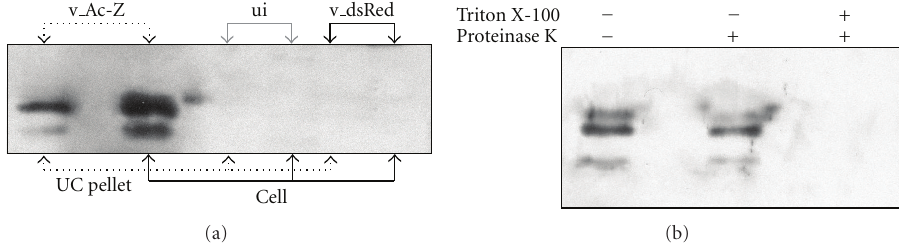
Figure 5: Western Blotting with α -Tio-Z-V5-His. (a) The ultracentrifugated supernatant (UC pellet) and cellular extract (Cell) of Sf9 cell fractions infected with recombinant v Ac-Z were loaded in lanes 1 and 2. The same fractions were loaded for uninfected cells (ui, lanes 3 and 4) and control v dsRed (recombinant baculovirus expressing dsRed protein, lanes 5 and 6). (b) Proteinase K protection assay. The treatment of the UC pellet samples (Triton X-100 1% and Proteinase K 0,1mg/ml) is indicated on the top of the